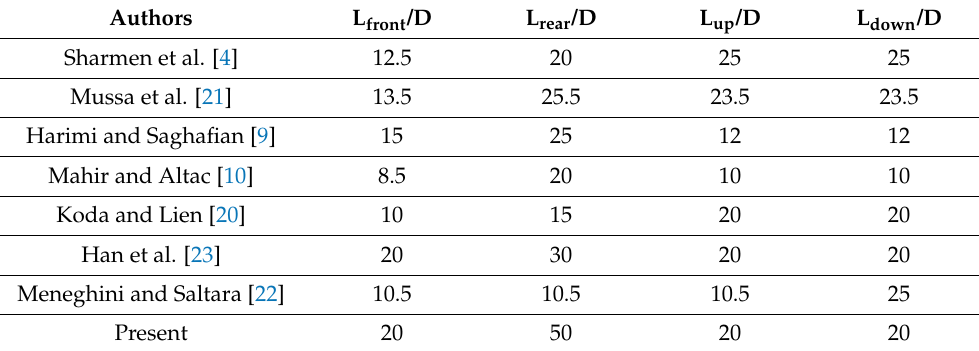
Table 3. Dimensions of computational domain for simulation of flow past a two-cylinder